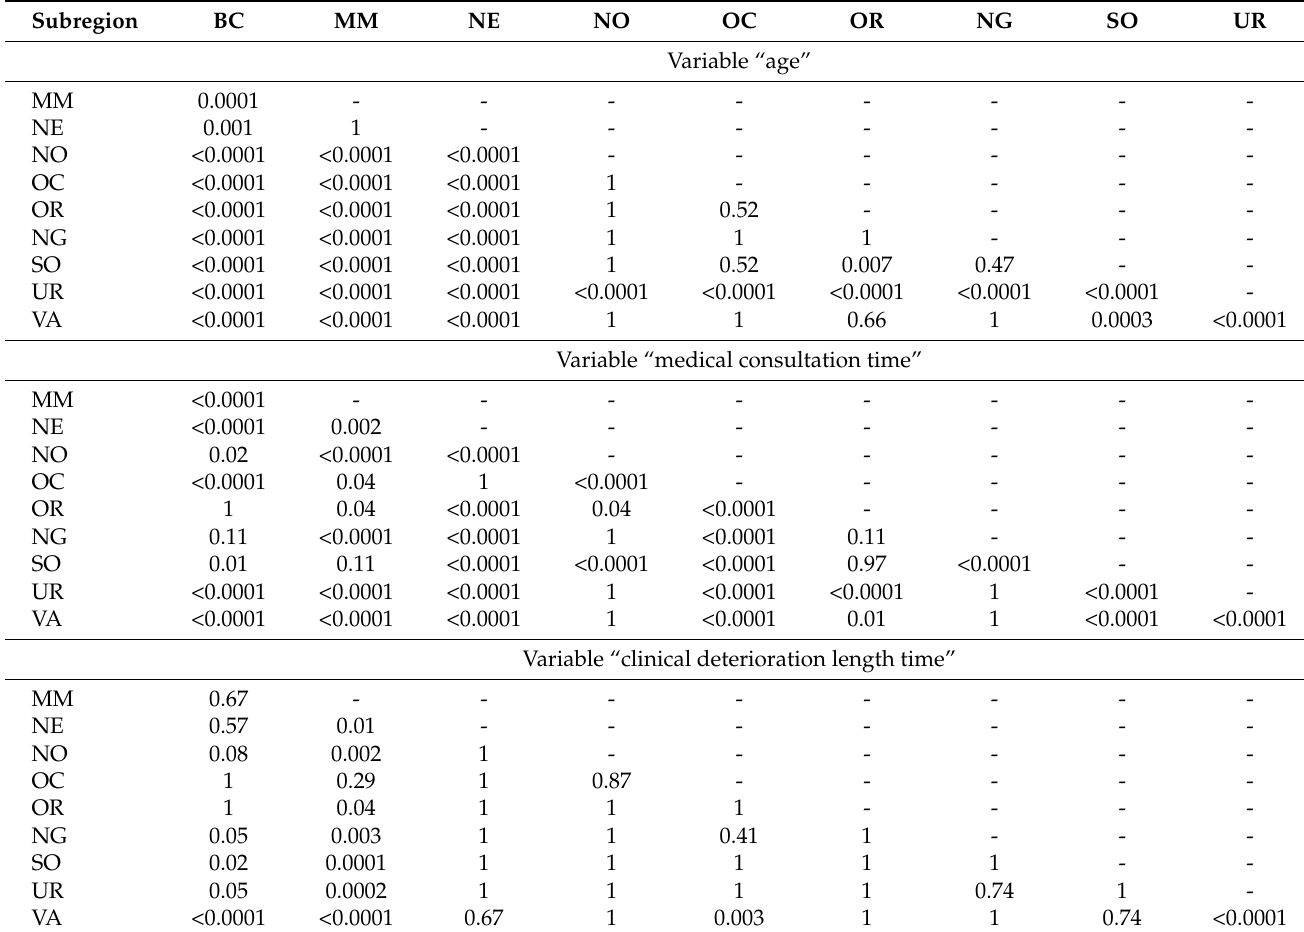
Table 7. MW test p -values for the quantitative variables that rejected the null hypothesis of the KW test by